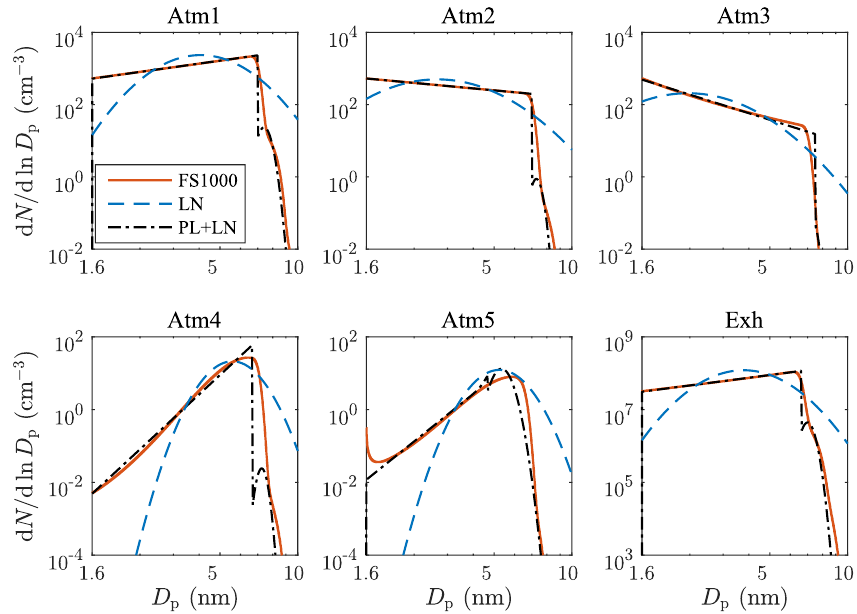
Figure 9. Particle size distributions at the ends of the test case simulations produced by different models. The input parameter sets are shown in Table 1. FS1000 denotes the fixed-sectional model with 1000 size sections. Note the different scales in the vertical axes on the bottom